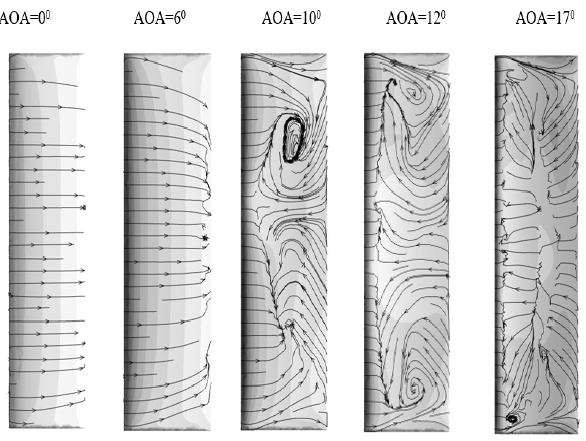
Figure 10. Streamlines for different angles of attack at the suction side of the normal